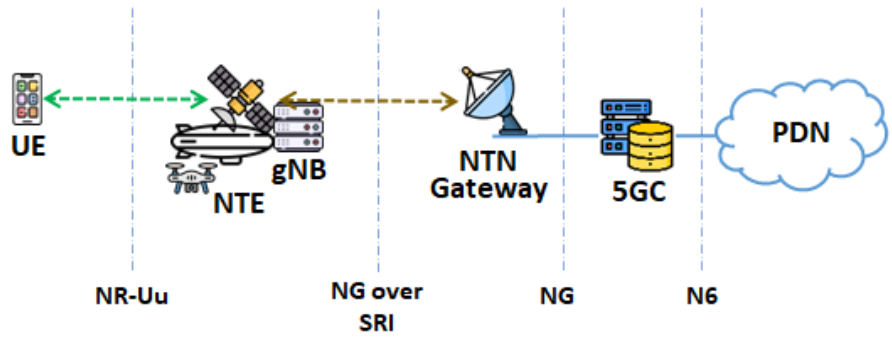
Figure 5. Regenerative NTN architecture.